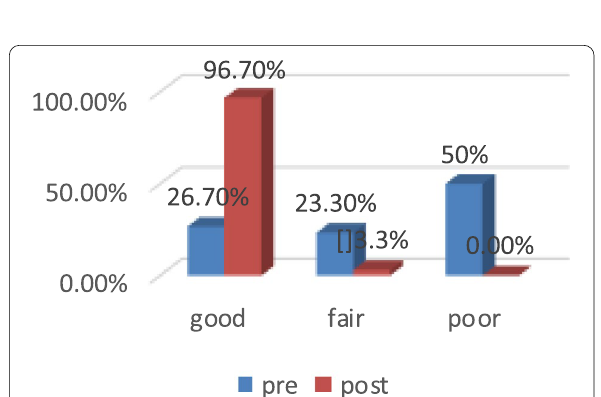
Fig. 5 Total intervention pre and post a psychoeducational intervention (